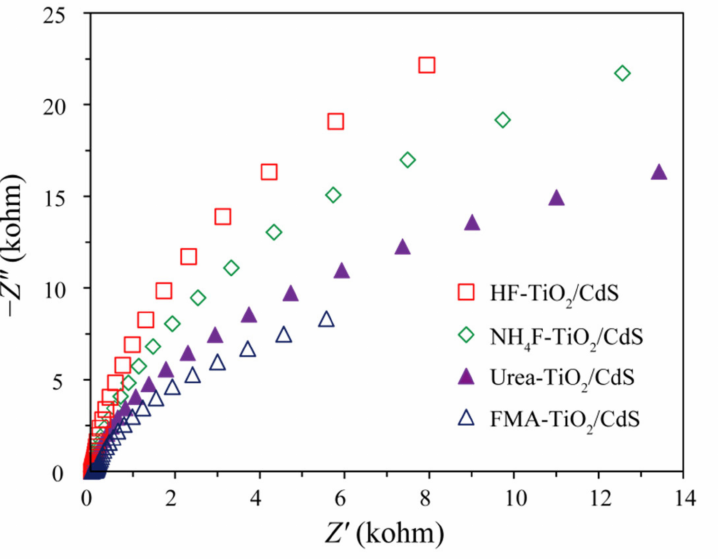
Figure 8. EIS Nyquist impedance plots of HF-TiO 2 /CdS, NH 4 F-TiO 2 /CdS, FMA-TiO 2 /CdS, and Urea-TiO 2 /CdS